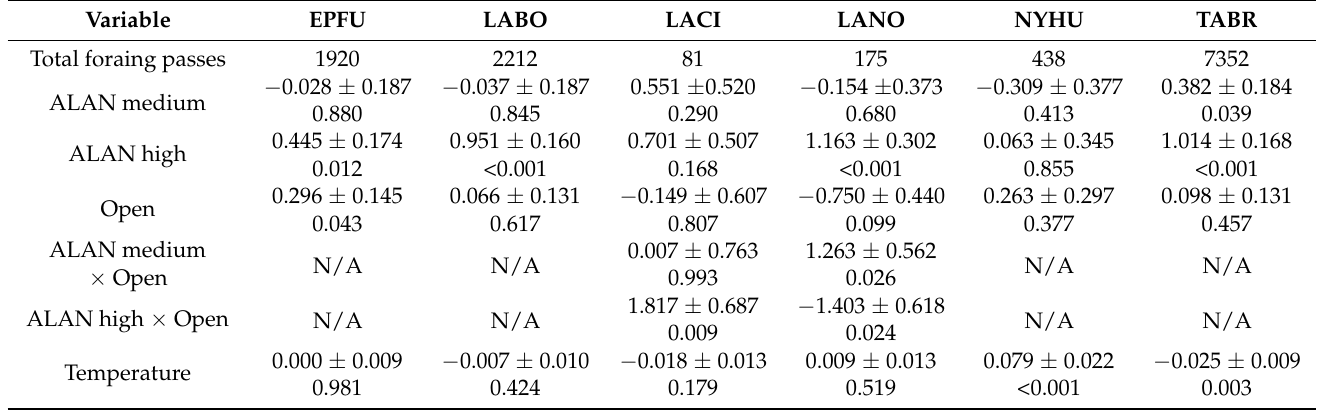
Table 3. General linear models results (regression estimate ± standard error on top, p value at bottom, n = 204) on species-specific foraging ratio in relation to ALAN, spatial complexity, and